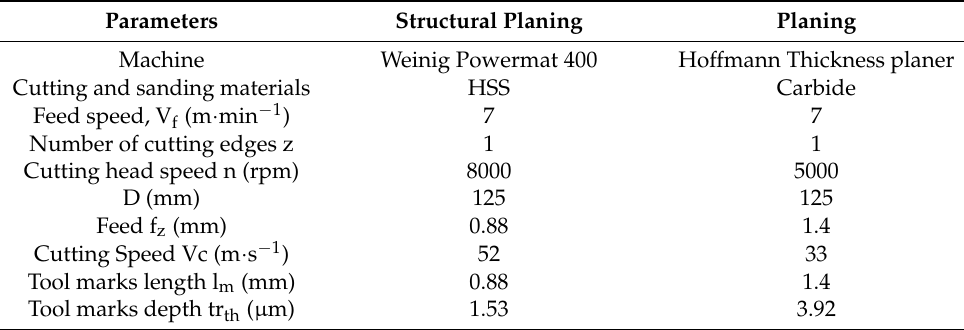
Table A1. Machining